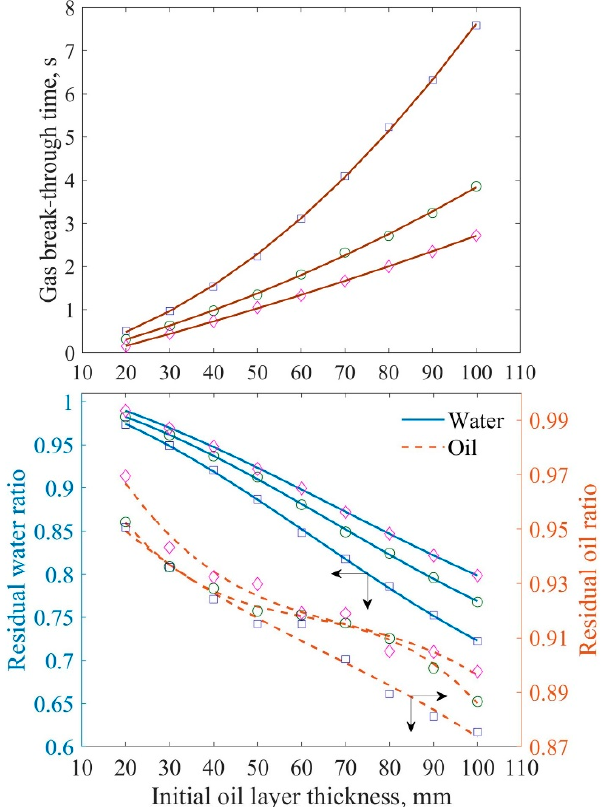
Figure 8. Upper panel: Effect of initial oil layer thickness on gas breakthrough time at different pressure differences. Lower panel: Effect of dimensionless initial oil layer thickness on residual ratios of both liquids at different pressure differences. Initial l–l interface level: 10 mm, oil viscosity: 0.131 Pa·s, pressure differences: 0.2 bar (squares), 0.3 bar (circles), and 0.4 bar (diamonds).